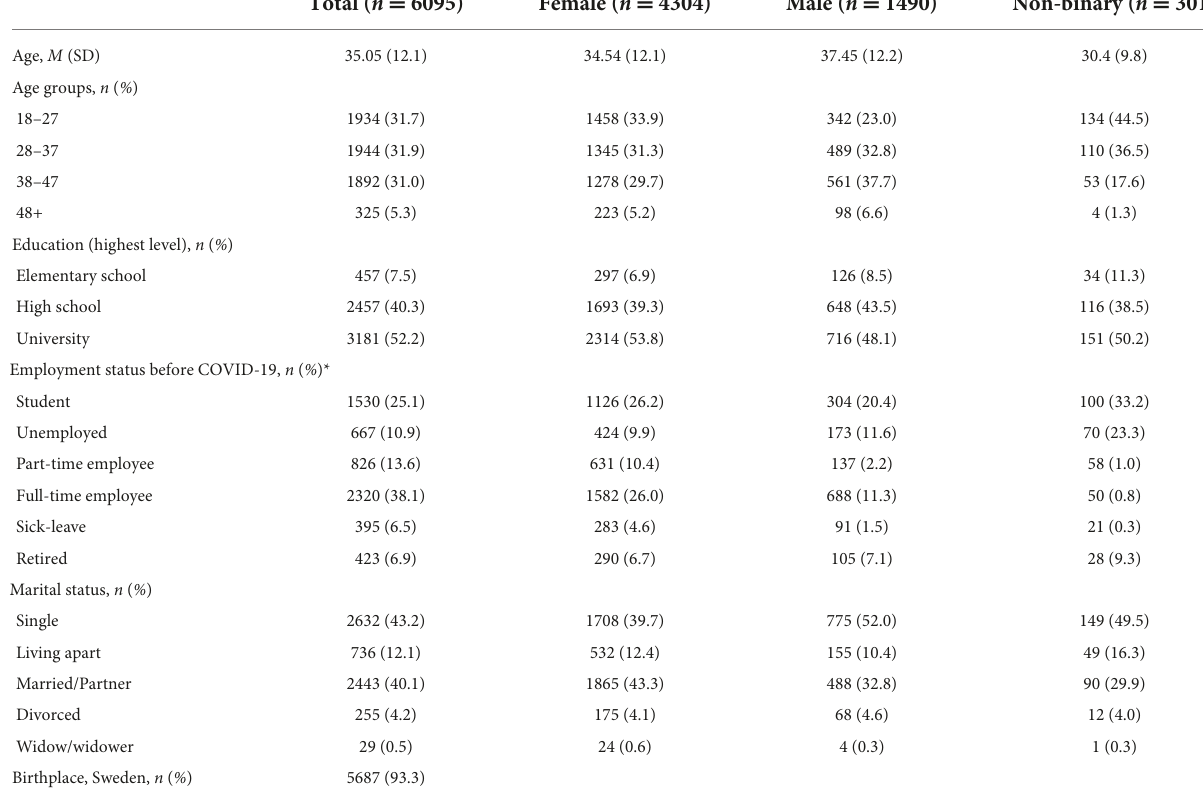
TABLE 4 Demographics of study